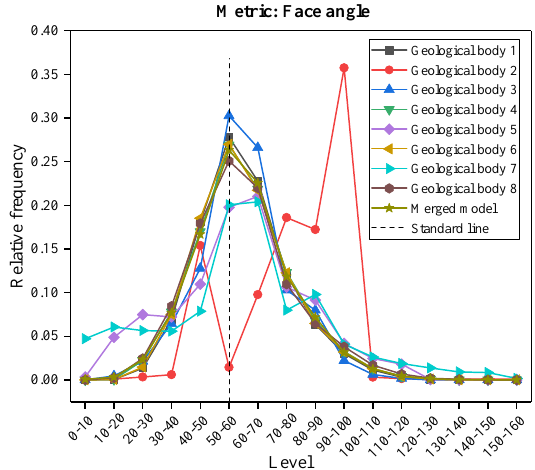
Figure 8. Statistics of the mesh quality of face